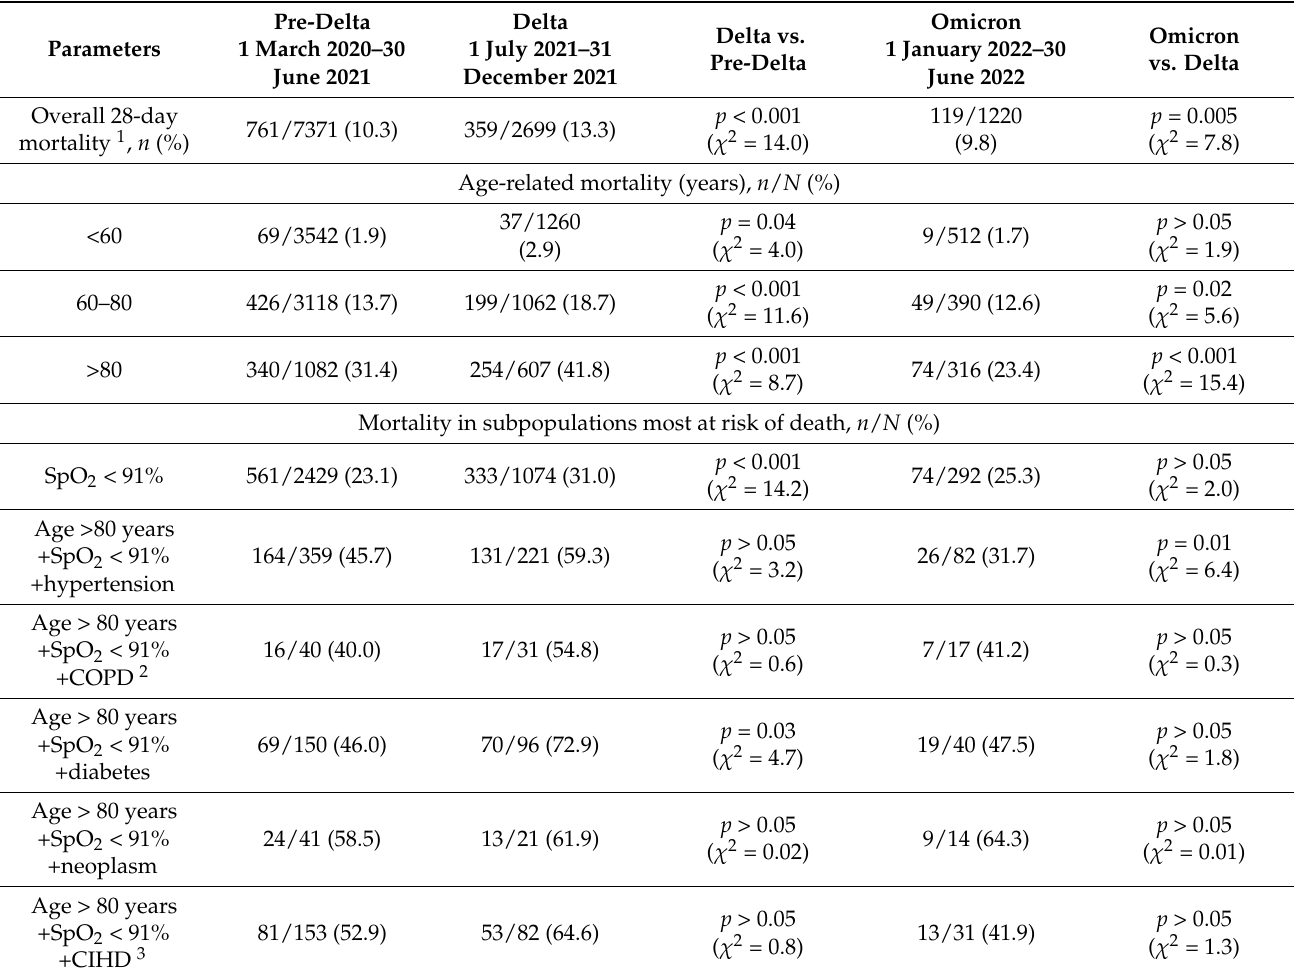
Table 4. The 28-day mortality rates during periods with the dominance of particular SARS-CoV-2